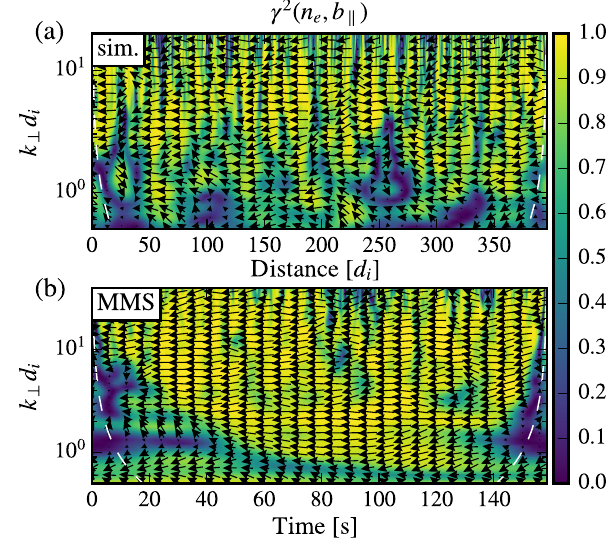
FIG. 6. Magnitude squared cross-coherence and phase between n and b in the simulation (a) and in the MMS interval (b). The e k orientation of the arrows (relative to the positive horizontal axis) denotes the phase. Dashed lines show the cone of influence